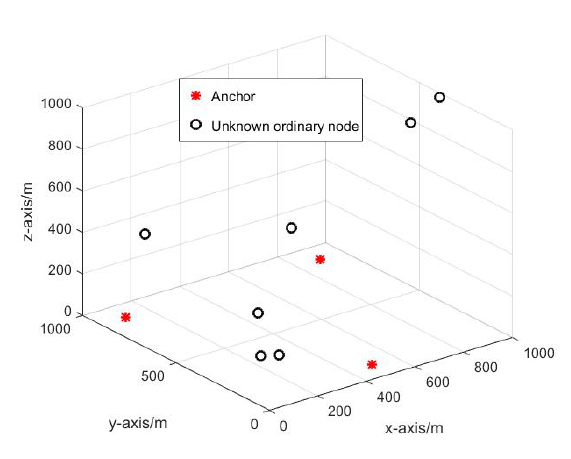
Figure 6. The initial topology of DUANs: red star is the anchor; black circle is the unknown ordinary